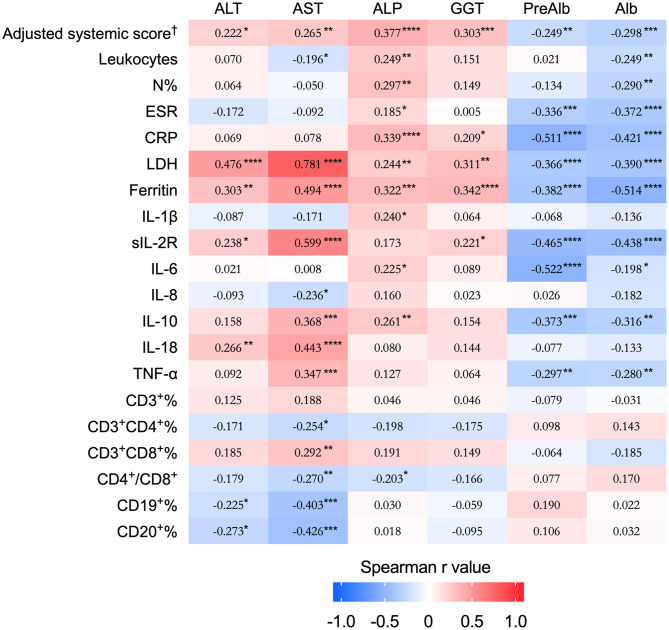
Correlation matrix of LFTs and prealbumin and albumin with disease activity score and laboratory parameters. The heat-map displays the Spearman's rank coefficient to show the correlation strength, and the significances are presented as *p < 0.05, **p < 0.01, ***p < 0.001, and ****p < 0.0001. †The adjusted systemic score excluded the item “hepatomegaly or abnormal liver function” from the calculation of the score. LFTs, liver function tests; ALT, alanine aminotransferase; AST, aspartate aminotransferase; ALP, alkaline phosphatase; GGT, gamma-glutamyl transpeptidase; preAlb, prealbumin; Alb, albumin; N%, the percentage of neutrophils; ESR, erythrocyte sedimentation rate; CRP, C-reactive protein; LDH, lactate dehydrogenase; IL, interleukin; sIL-2R, soluble receptor of IL-2; TNF, tumor necrosis factor.